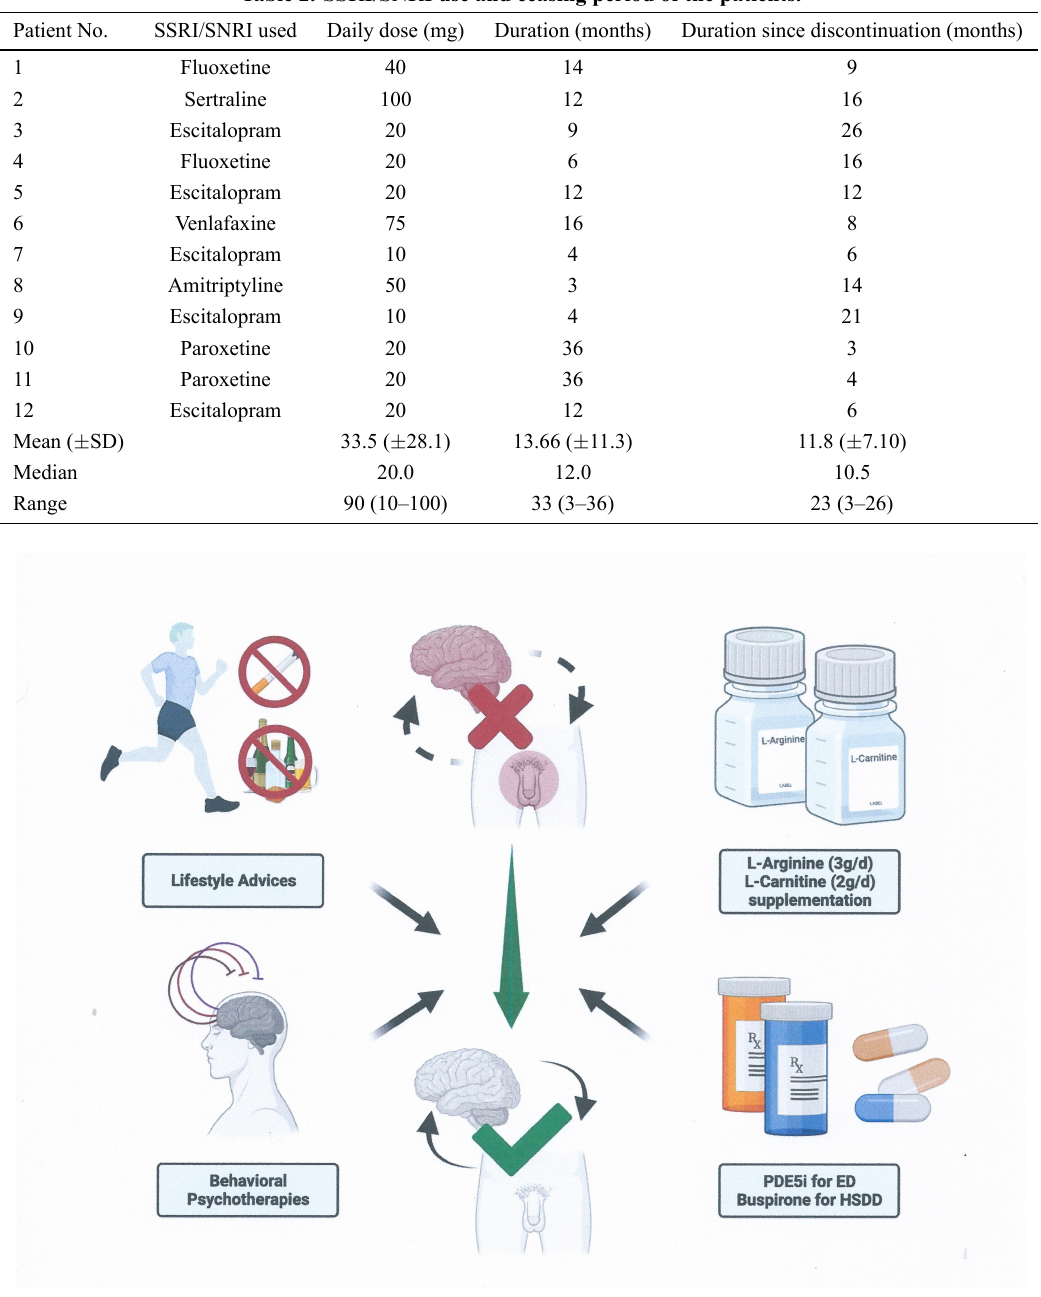
Fig. 1. PSSD is frequently described by the patients as a “disconnection” between the brain and the genitals, featuring lack of libido, anorgasmia, ejaculatory-orgasm delay and genital anesthesia. The present multimodal approach consists of systems sexology and bio-psycho-social interventions aiming at restoring such brain-genital connection and achieving a better sexual